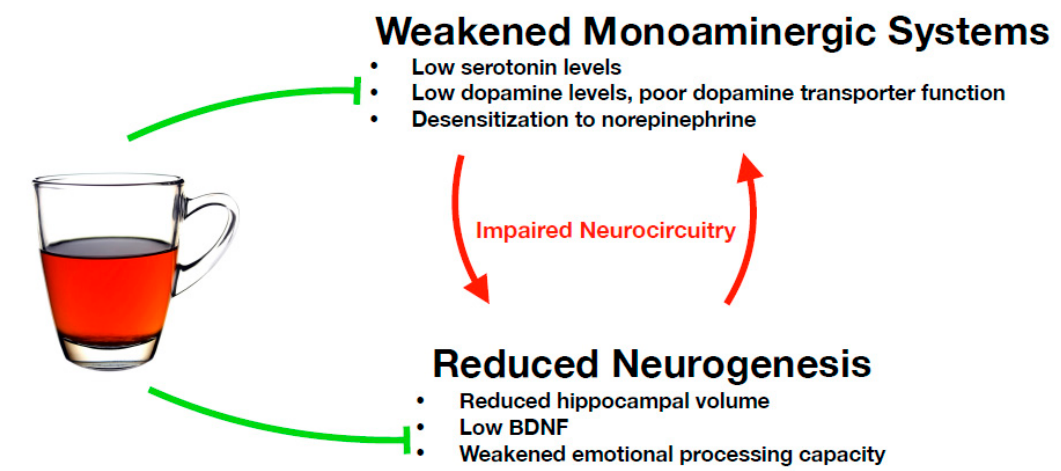
Figure 3. The positive feedback loop of weakened monoaminergic systems and reduced neurogenesis. Weakened monoaminergic systems and reduced neurogenesis represent two mechanistic nodes within an interrelated system of depression pathology. Bullet points identify symptoms of weakened functional status, and key targets for tea phytochemicals. Green lines represent attenuating effect, while red lines represent exacerbating effect. BDNF, brain-derived neurotrophic factor.